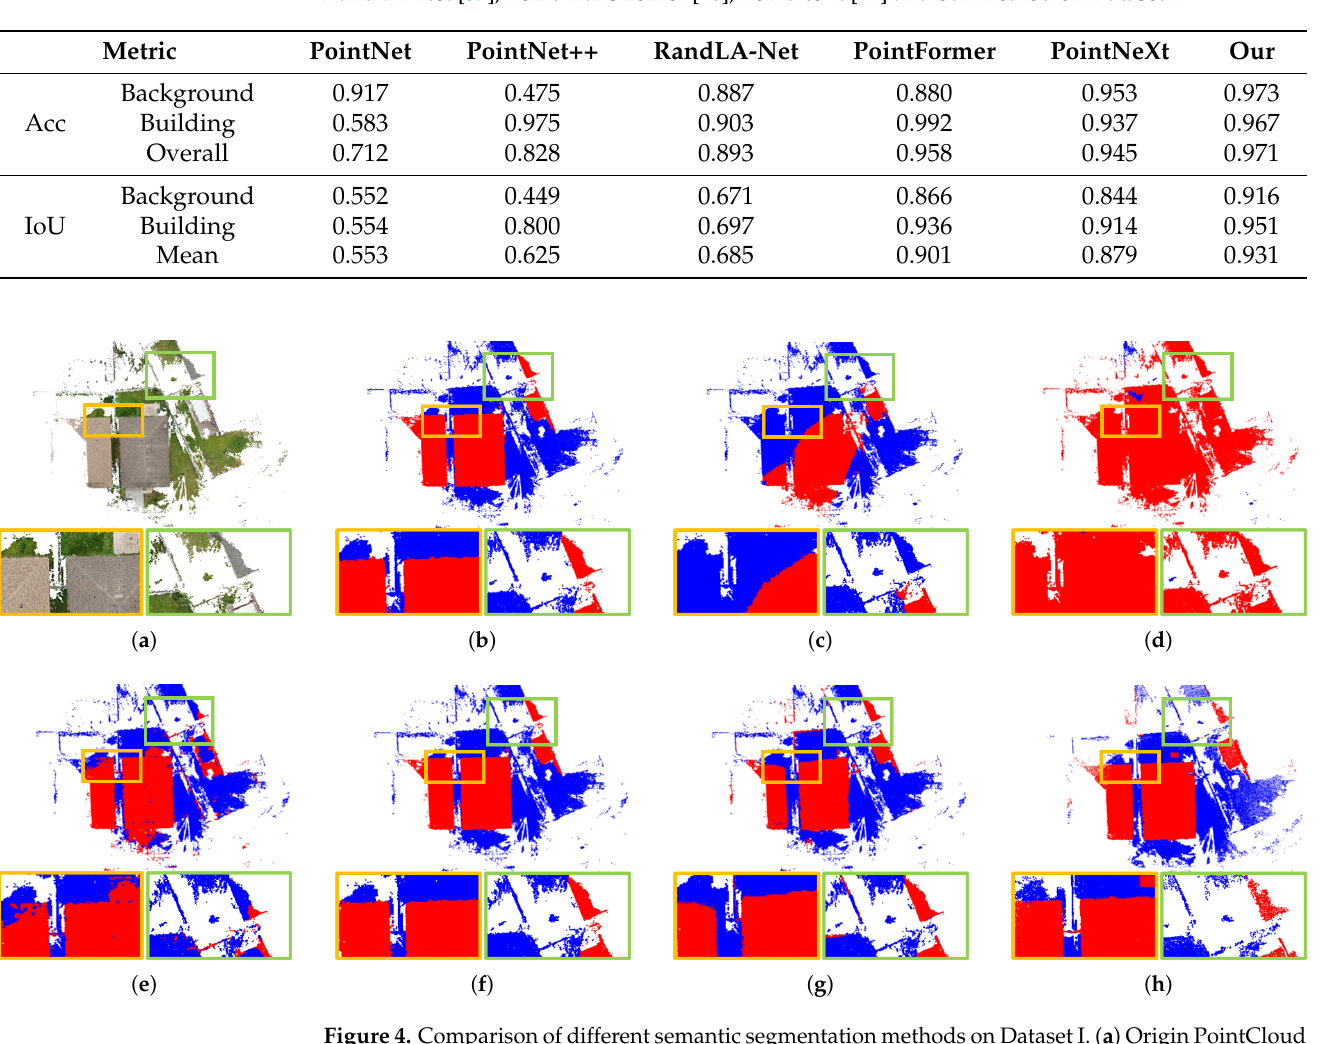
Table 1. Comparison of different point cloud segmentation methods for PointNet [1], PointNet++ [2],